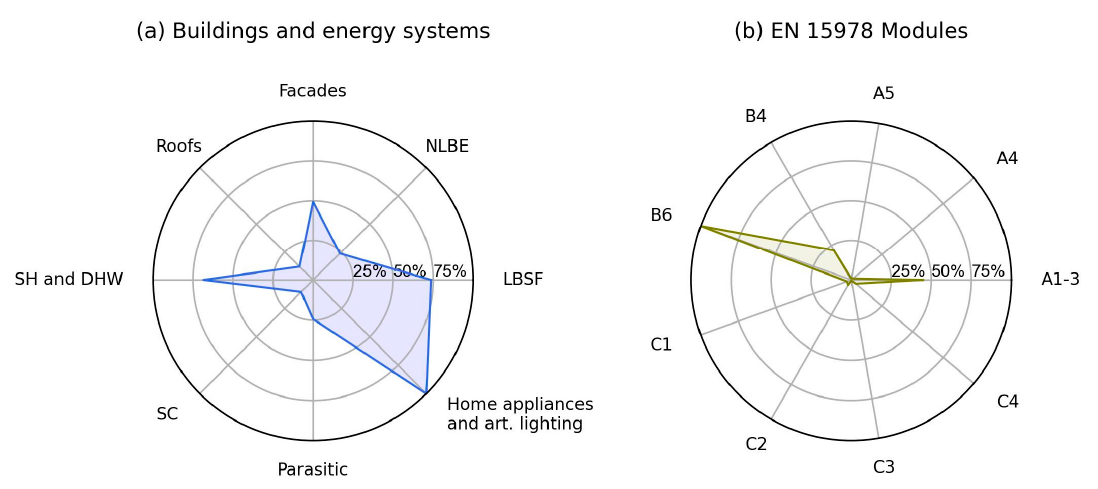
Figure 9. Percentage results by ( a ) contributors and ( b ) modules.